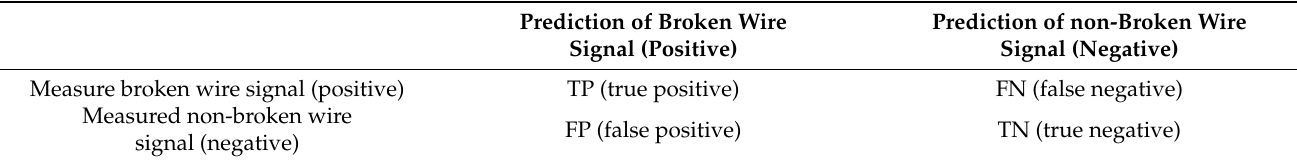
Prediction of non-Broken Wire Signal (Negative)